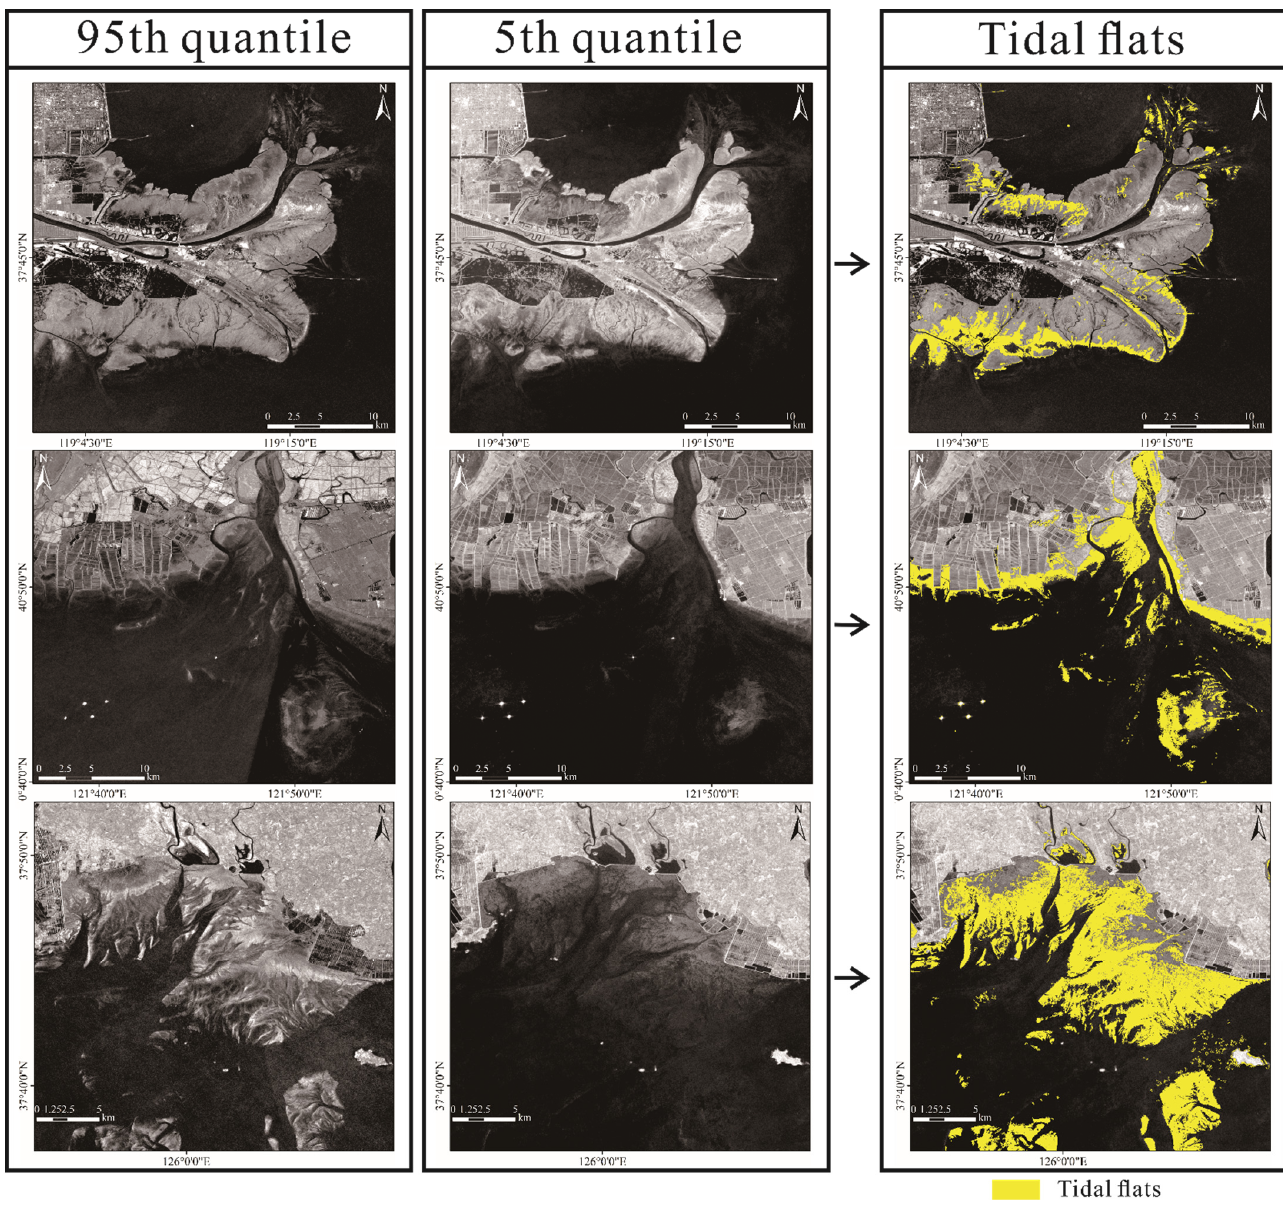
Figure 10. Case study results of quantile synthesis method through SAR imagery over the Yellow River Delta ( the first row ), Liao estuary ( the second row ), and Hajeu bay ( the last row ). The tidal flat maps were overlaid on 5th quantile images.